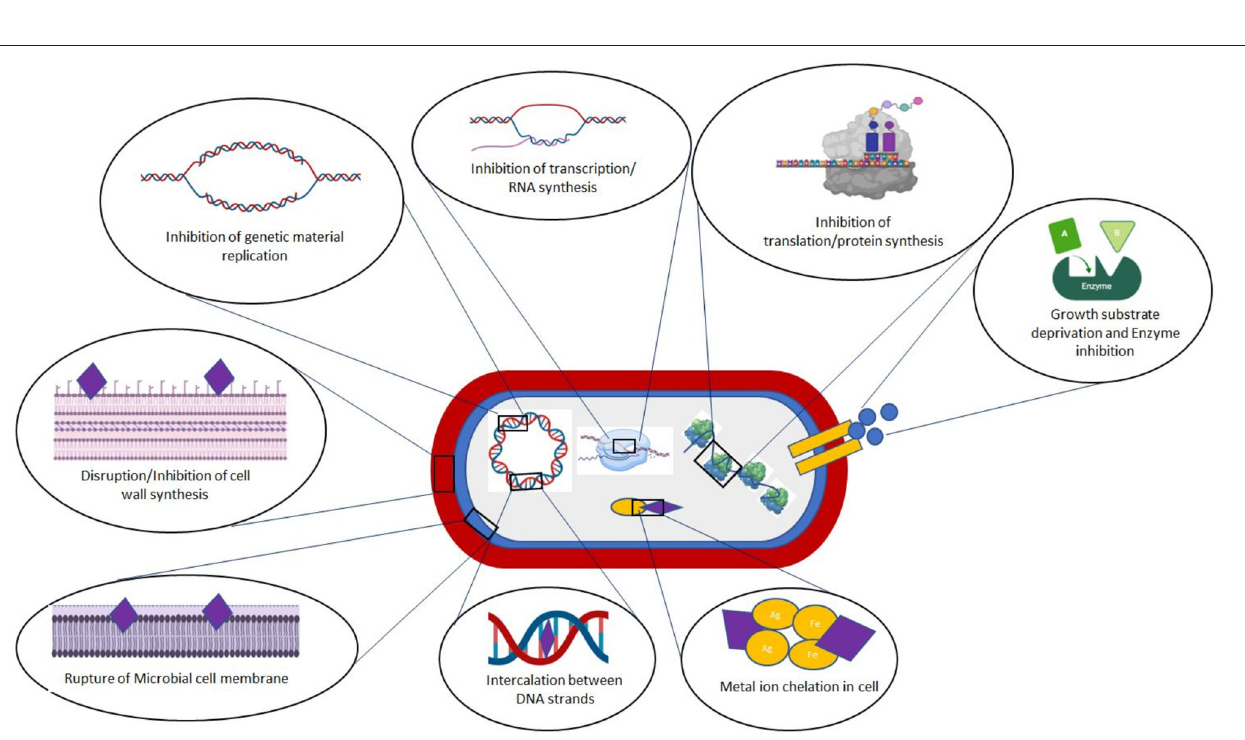
FIGURE 2 | Mechanisms of action of plant-based antimicrobial